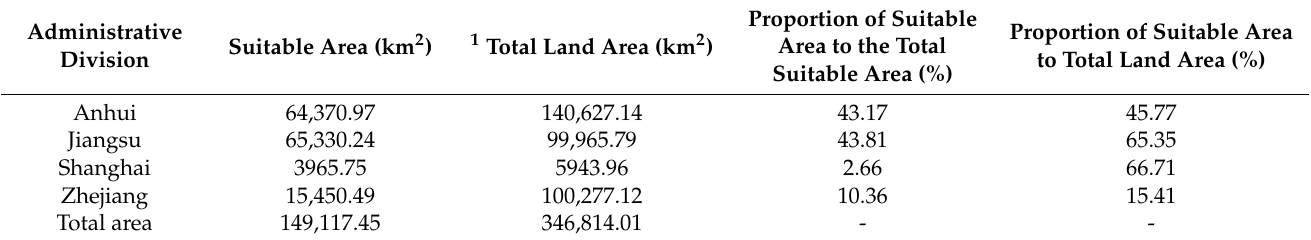
Table 3. Suitable areas in each administrative division in the Yangtze River Delta region (YRDR).